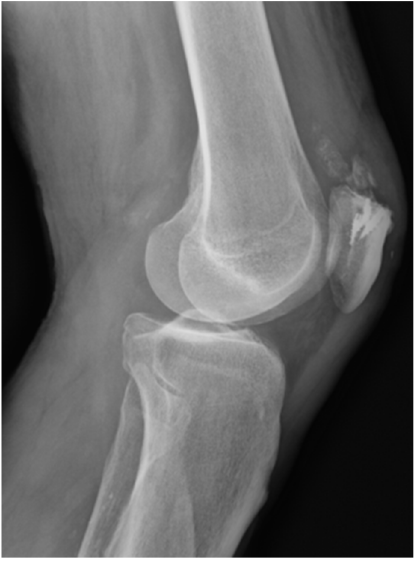
Figure 1. Quadriceps reconstruction after its rupture by mean of 4 TWINFIX. Indications for surgery included 24 patients with LET during Anterior Cruciate Ligament (ACL) reconstruction (in anterolateral margin of the proximal tibia at half of distance between head of fibula and Gerdy ´ s tubercle), two patients with extra-capsular MPFL reconstruction (on the medial margin of the patella ´ s border), three patients with quadriceps or patellar tendon repair (inside of the respective bone), and four with MCL repair (on the medial aspect of the proximal tibia, or close to the epicondyle targeting the anatomic footprint of MCL) (Figure 2).